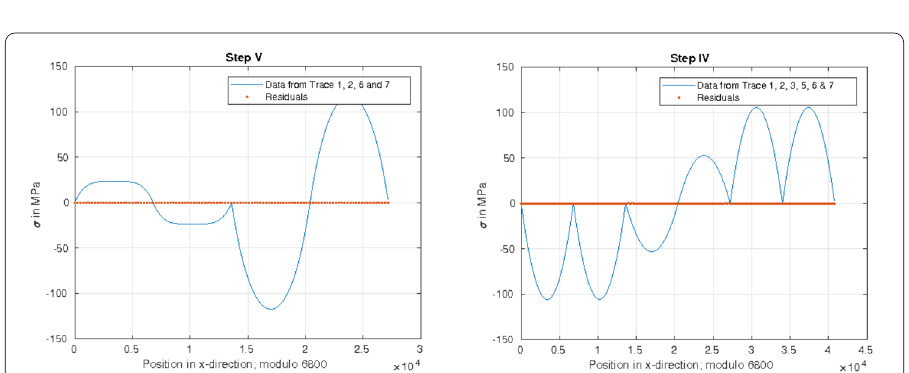
Figure 11 Left: Update of the estimation of M y . Right: Update of the estimation of M z + M w and termination